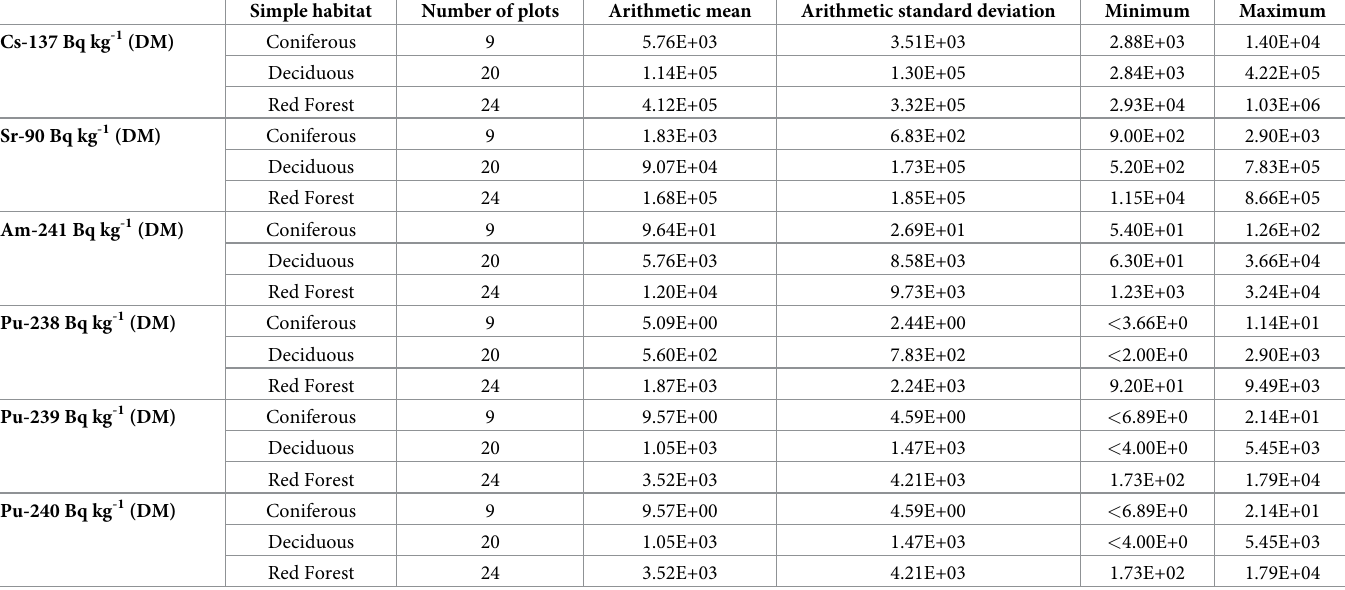
Table 1. Radionuclide activity concentrations in soils summarised by simple habitat.